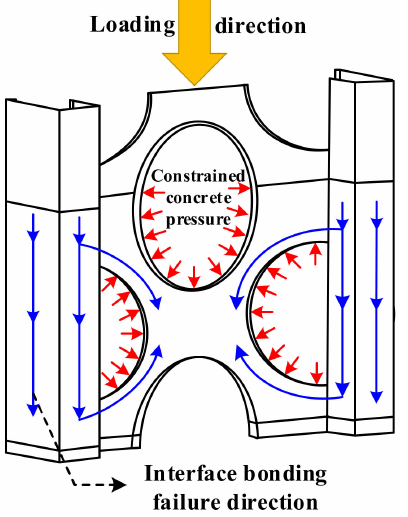
Figure 25. Sketch of interface bonding-failure